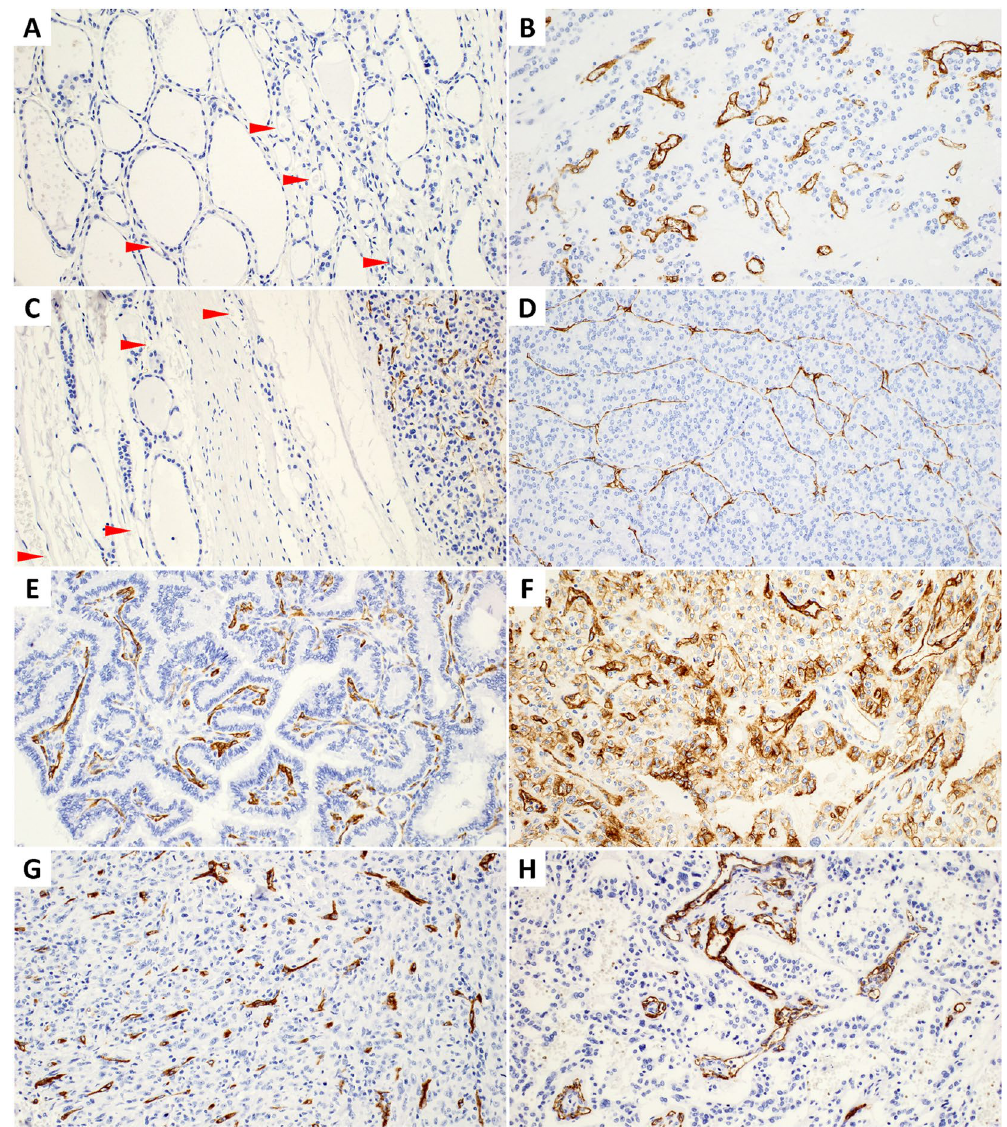
Figure 1. PSMA immunoreactivity in representative thyroid samples. PSMA is expressed by endothelium of thyroid tumors ( B – H ), but not of benign thyroid ( A , C ). Arrowheads indicate microvessels with red blood cells in non-neoplastic thyroid tissue. Note absence of PSMA expression by benign or neoplastic epithelium, except one case of PDTC ( F ). ( A ) Benign thyroid. ( B ) Follicular adenoma. ( C ) Interface between follicular cancer and adjacent thyroid tissue. PSMA expression is restricted to the tumor microvasculature. ( D ) Follicular thyroid carcinoma. ( E ) Papillary thyroid carcinoma, classic variant. PSMA-positive capillaries decorate papillary cores. ( F ) Poorly differentiated thyroid carcinoma with ectopic PSMA expression by cancer cells added by predictable immunoreactivity in tumor-associated endothelium. ( G ) Anaplastic thyroid carcinoma. ( H ) Medullary thyroid carcinoma. Immunohistochemistry, 200 × ( A – H